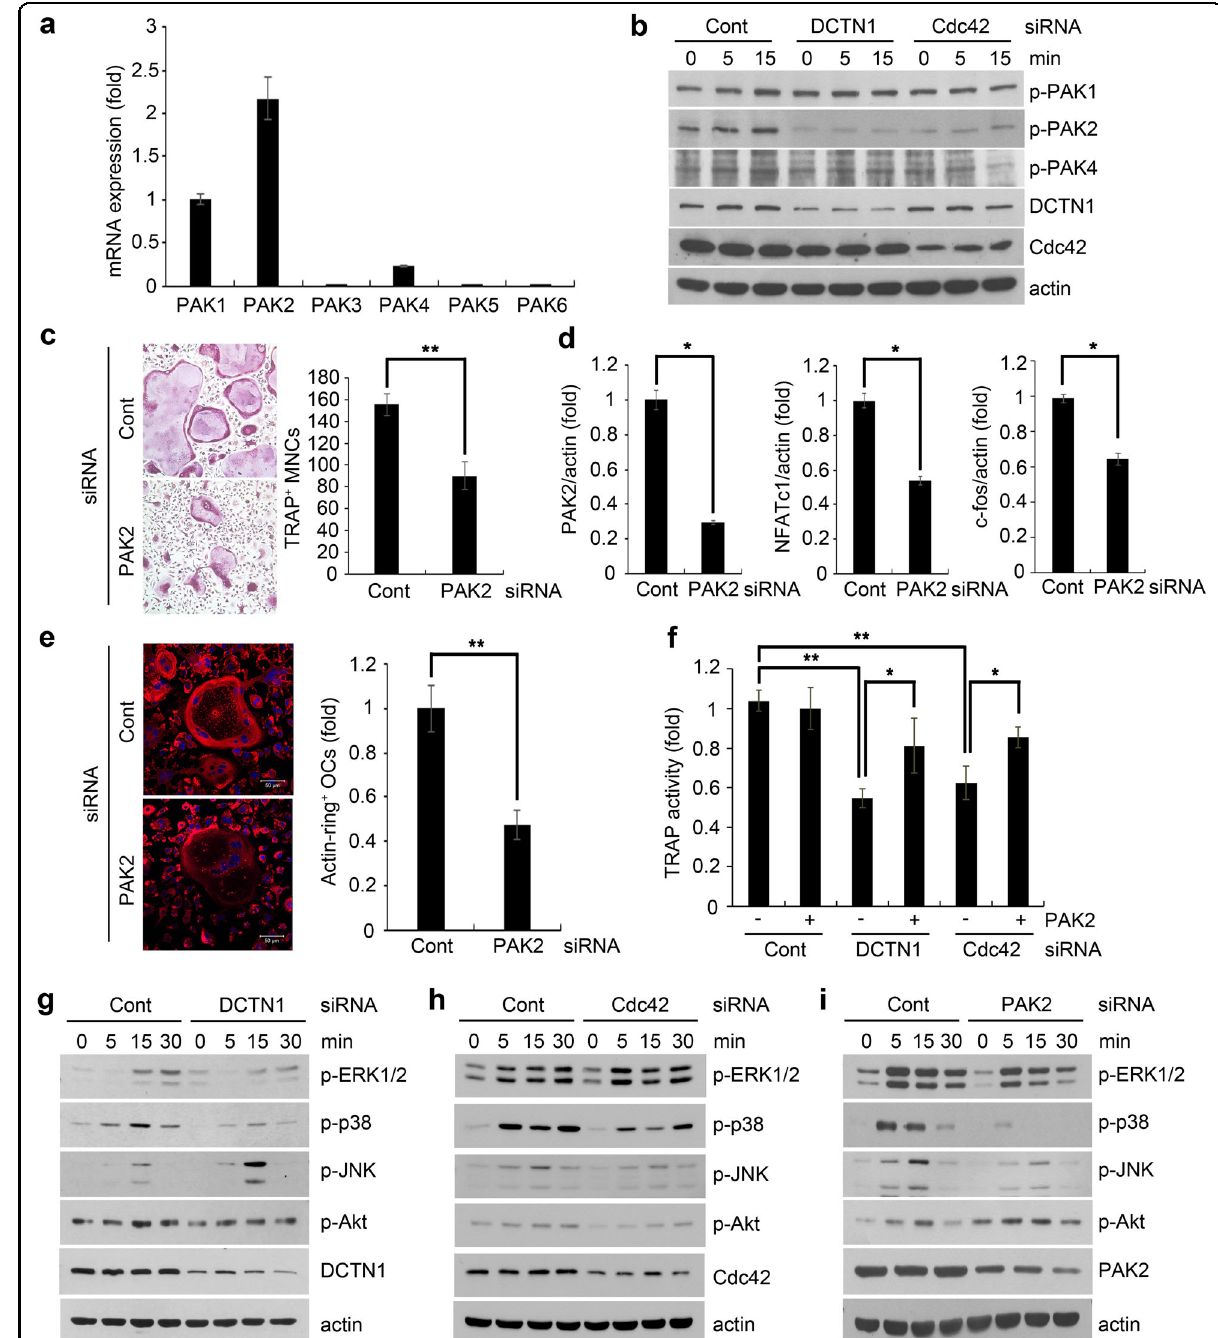
Fig. 4 PAK2 is a downstream target of Cdc42 in the DCTN1-mediated regulation of OC differentiation. a BMMs were treated with ODM for 48 h. PAK1-6 mRNA levels were analyzed by real-time PCR. b BMMs were transfected with control, DCTN1, or Cdc42 siRNA. The cells were treated with RANKL (400ng/ml) for the indicated time after serum starvation for 6 h. The phosphorylation of PAK1, PAK2, and PAK4 was determined by western blotting. c , d BMMs were transfected with control or PAK2 siRNA. The cells were cultured in ODM for 4 days and stained for TRAP. TRAP-positive multinucleated cells were counted. PAK2, NFATc1, and c-Fos mRNA levels were analyzed by real-time PCR. e BMMs transfected with siRNA were cultured on dentin slices in ODM for 9 days. To visualize the actin-ring structure, the cells were stained with Alexa Fluor 633-conjugated phalloidin. f BMMs infected with a retrovirus harboring PAK2 or mock DNA were transfected with control, DCTN1, or Cdc42 siRNA. The cells were cultured in ODM for 5 days, and TRAP activity was measured in cell lysates. g , h , i BMMs were transfected with control, DCTN1, Cdc42, or PAK2 siRNA. The cells were treated with RANKL (400ng/ml) for the indicated time after serum starvation for 6 h. The phosphorylation of ERK1/2, p38, JNK, and Akt was determined by western blotting. * p < 0.05, ** p < 0.005 compared with